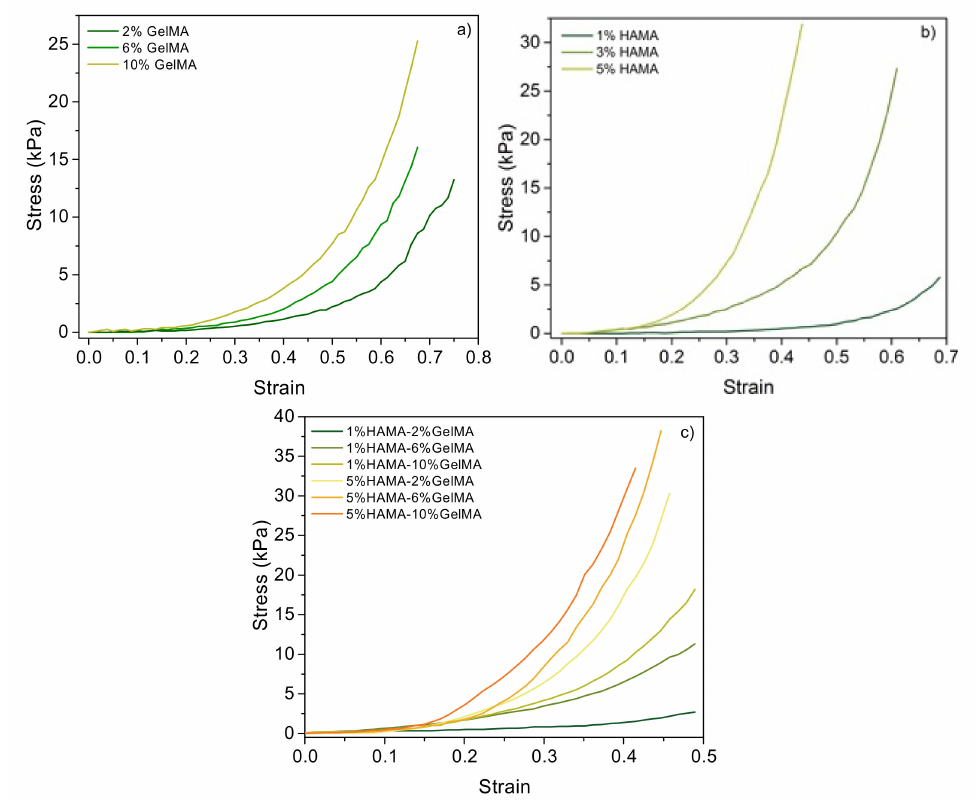
Figure A4. Compression tests for pure ( a ) GelMA and ( b ) HAMA scaffolds and for hybrid ( c ) GelMA–HAMA of different compositions. Concentrations are indicated in the